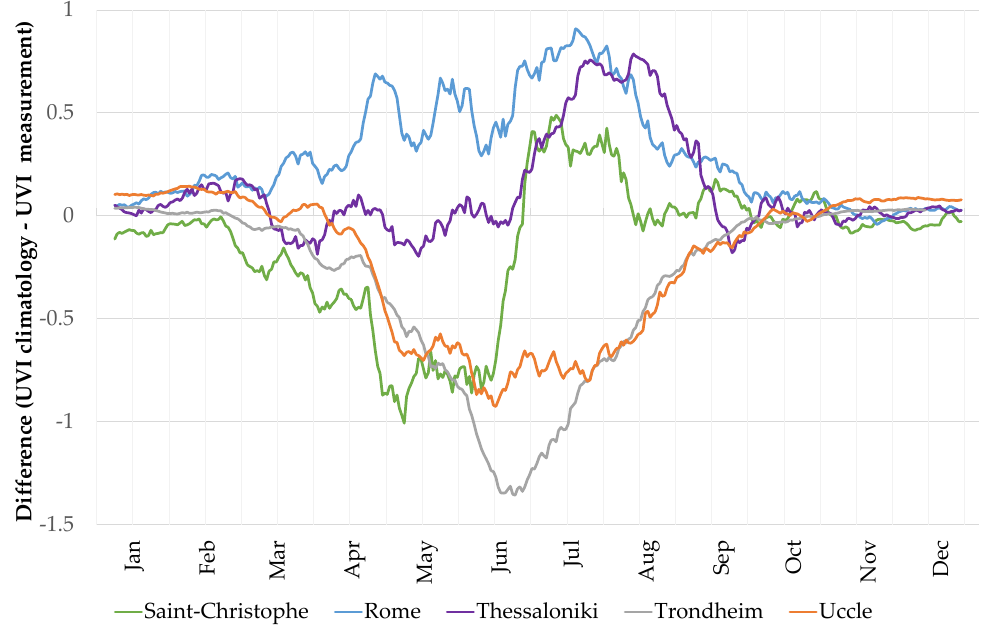
Figure 10. Mean difference between the noontime satellite-based UVI from the climatology and the noontime ground-based UVI measurements in Saint-Christophe, Rome, Thessaloniki, Trondheim and Uccle during the time period 2005–2015, shown as smoothed averages for a ±7 days